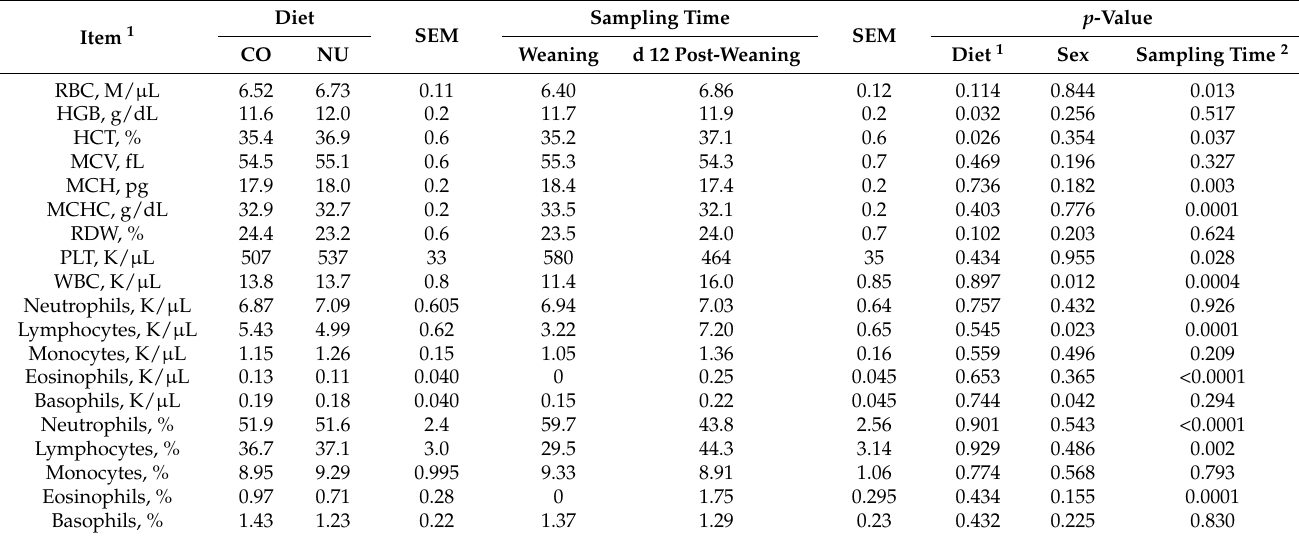
Table 3. Blood data obtained on fresh samples, for subjects sacrificed at weaning and 12 days